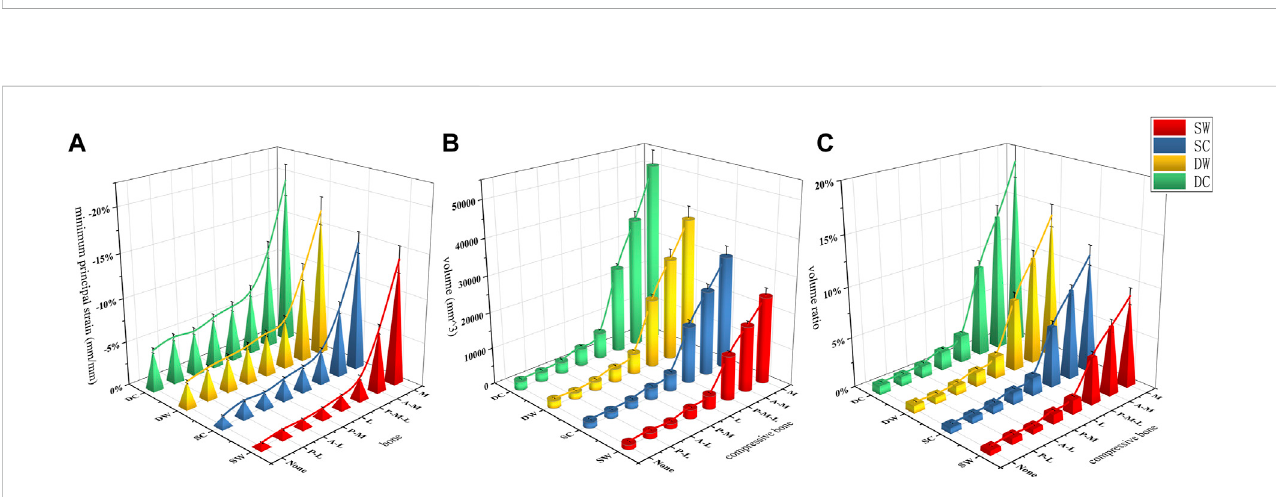
FIGURE 10 Theminimumprincipalstrain,theriskycompressivebonevolume,andthevolumeratiocurvesofthebonemodelswereexhibitedin (A – C)